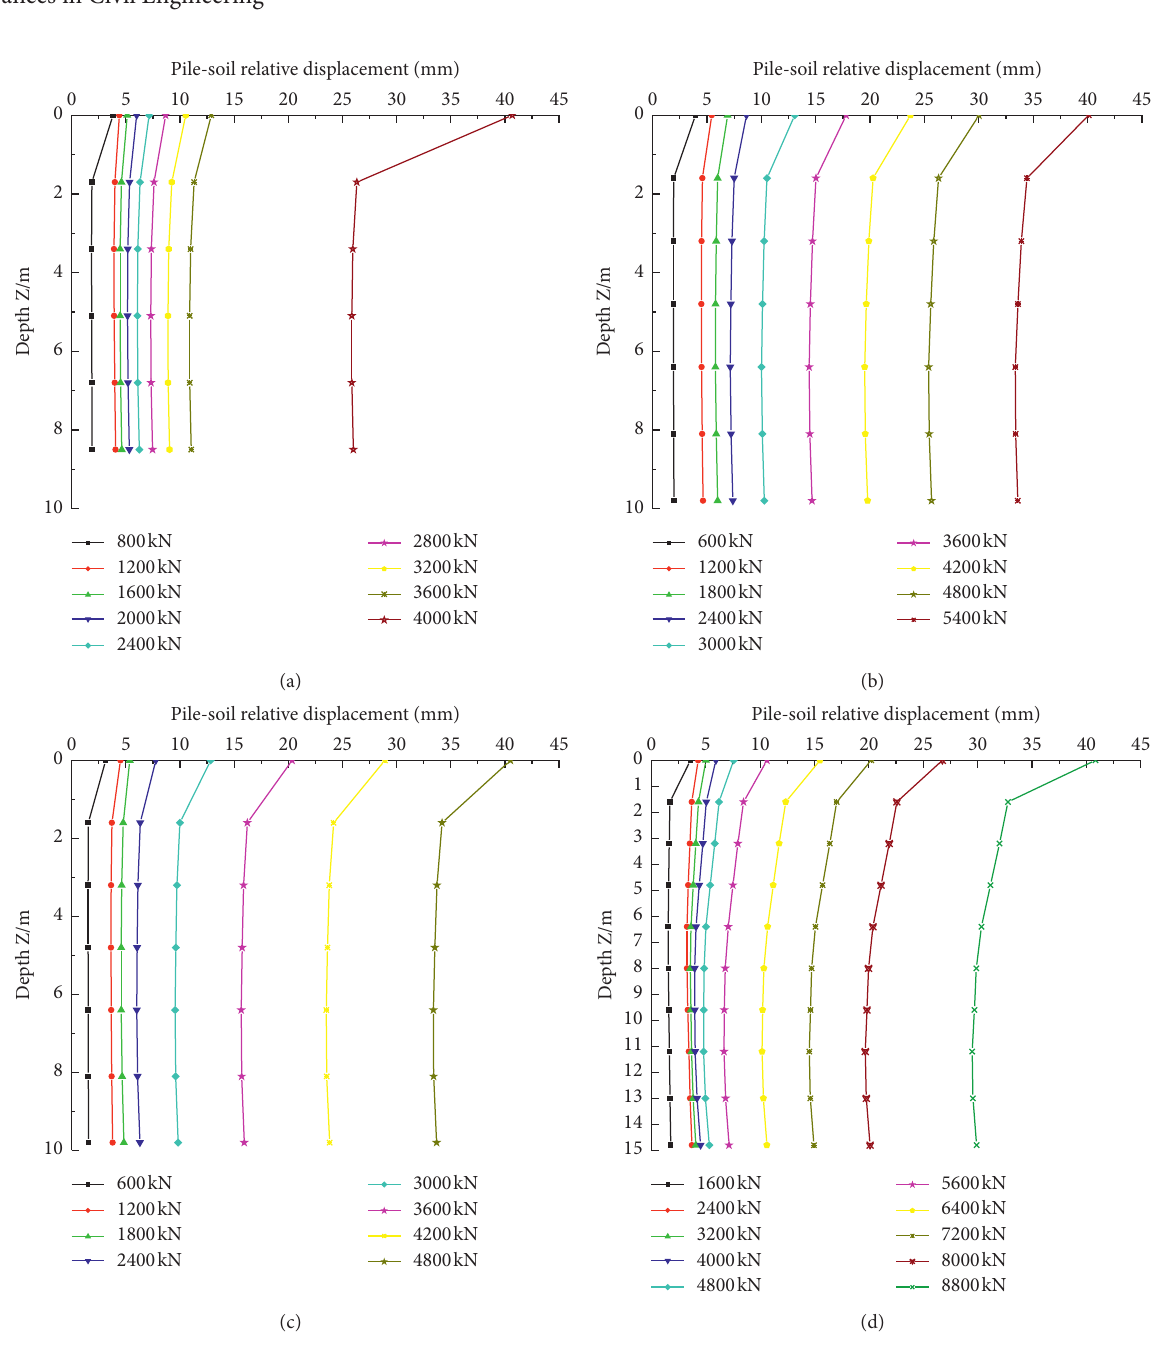
Figure 12: Pile-soil relative displacement curve. (a) No. 1 pile. (b) No. 2 pile. (c) No. 3 pile. (d) No. 4